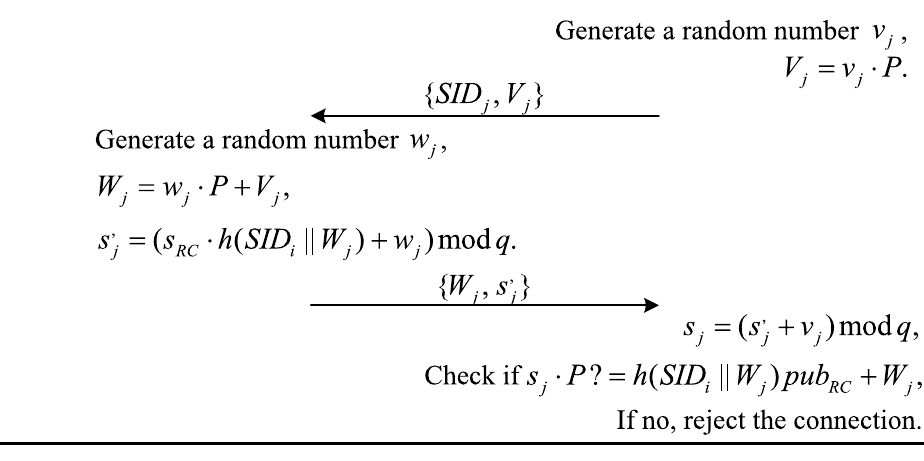
Fig 1. User and server registration phases of the proposed